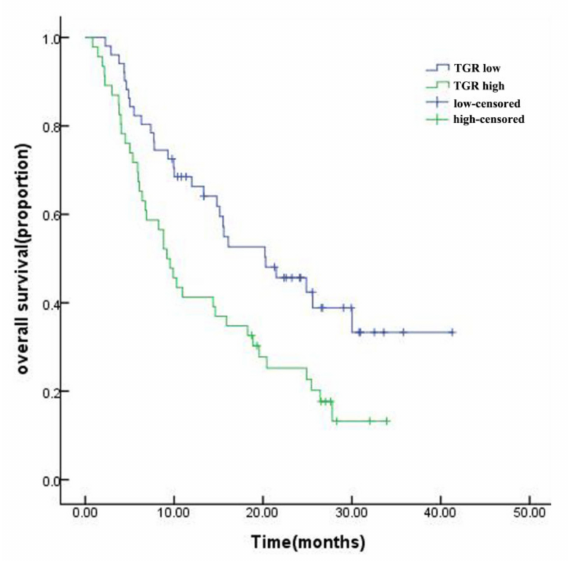
Figure 3. Kaplan–Meier survival curve for HHCC patients in the high-TGR and low-TGR groups.